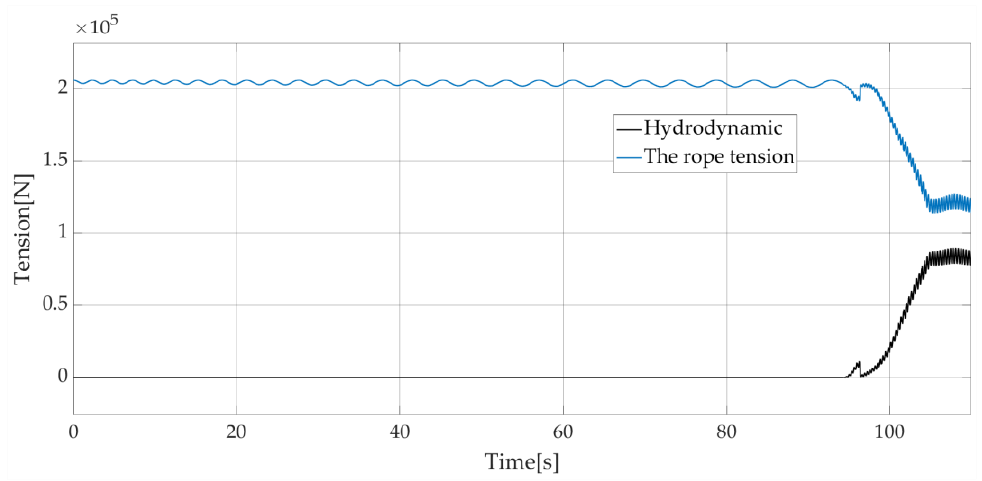
Figure 18. L = 5 m, V = 0.2 m/s rope tension and hydrodynamic forces on the load with wave synchronization.